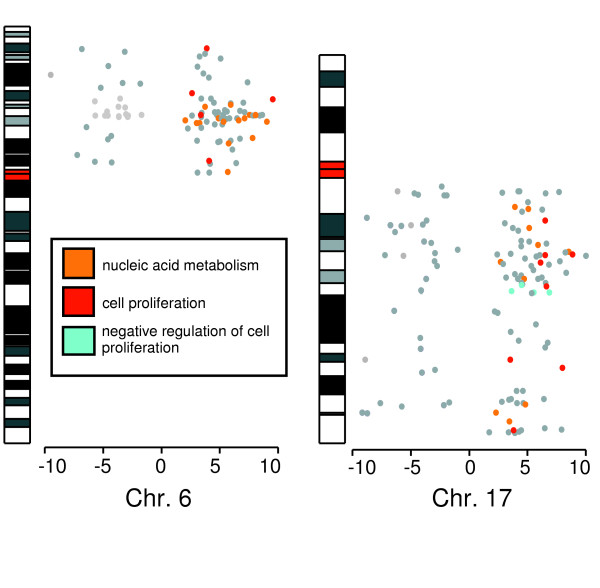
Functional classification of differentially expressed genes on 6p and 17q. Genes on chromosome 6p and chromosome 17q that are differentially expressed in HCC compared to adjacent non-cancerous tissue were identified as described in the Material and Methods. The t-statistic corresponding to each misregulated gene (p < 0.05) was plotted with respect to gene location. For consistent plotting, t-statistics > 10 and t-statistics < -10 were set to 10 and -10 respectively. Genes classified as nucleic acid metabolism, cell proliferation, and negative regulation of cell proliferation are highlighted orange, red, and cyan, respectively.